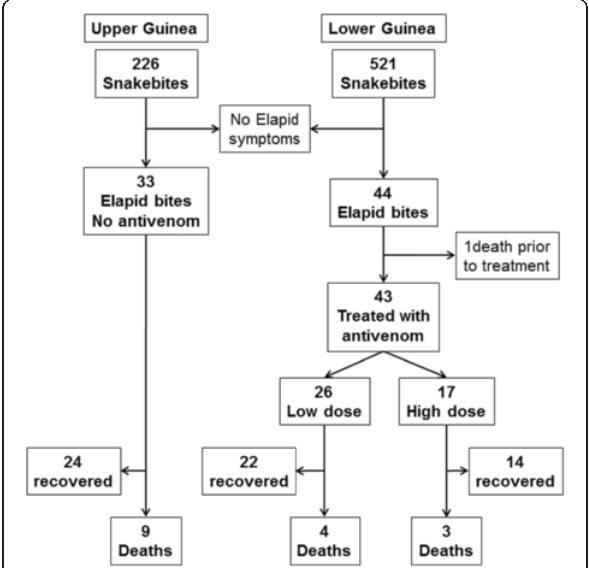
Figure 2 Flow chart of inclusion and outcome of patients from Upper and Lower